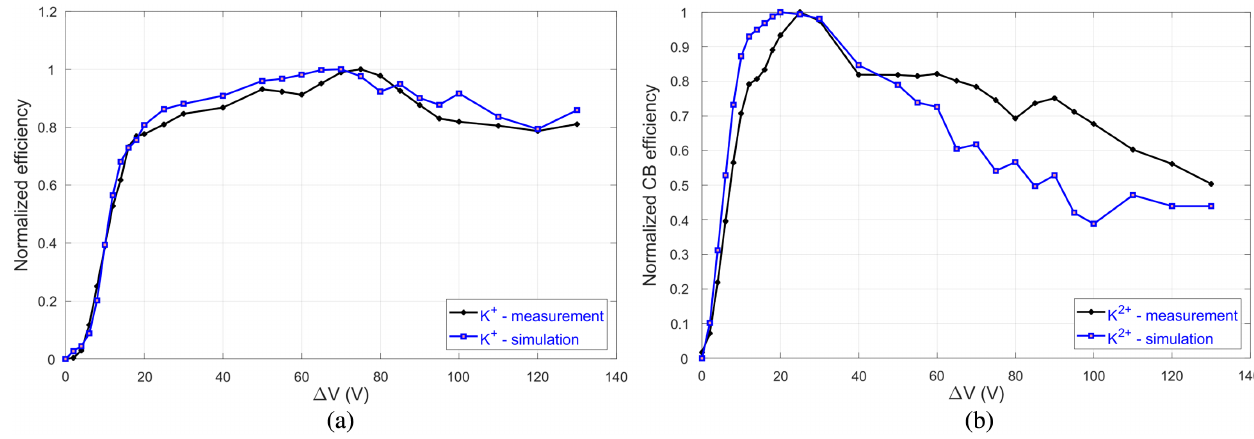
FIG. 11. Comparison of experimental and simulated (a) K 1 þ and (b) K 2 þ Δ V curves obtained from He plasma parameters. n 2 × 10 11 cm − 3 (for 207 W of rf power) and k T